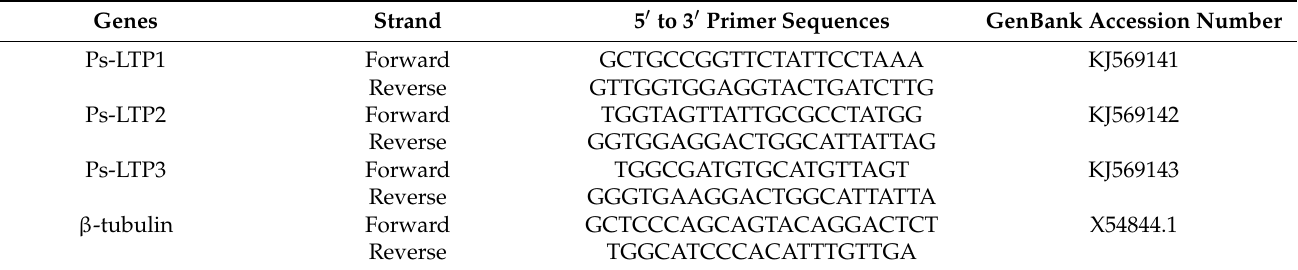
Table 1. Sequences of primers used for